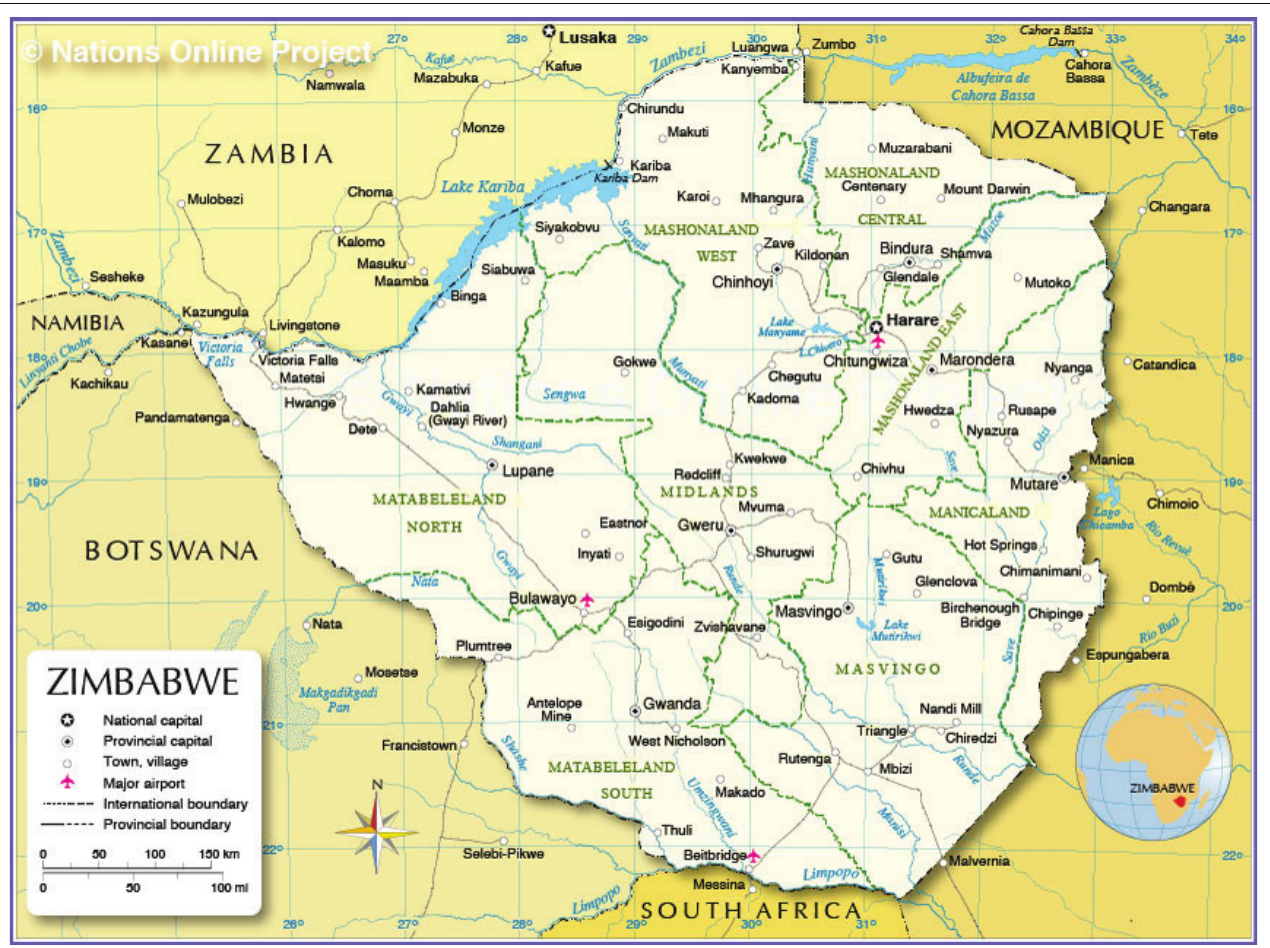
FIGURE 2: Zimbabwe, provinces, capital, Harare, and towns and villages.